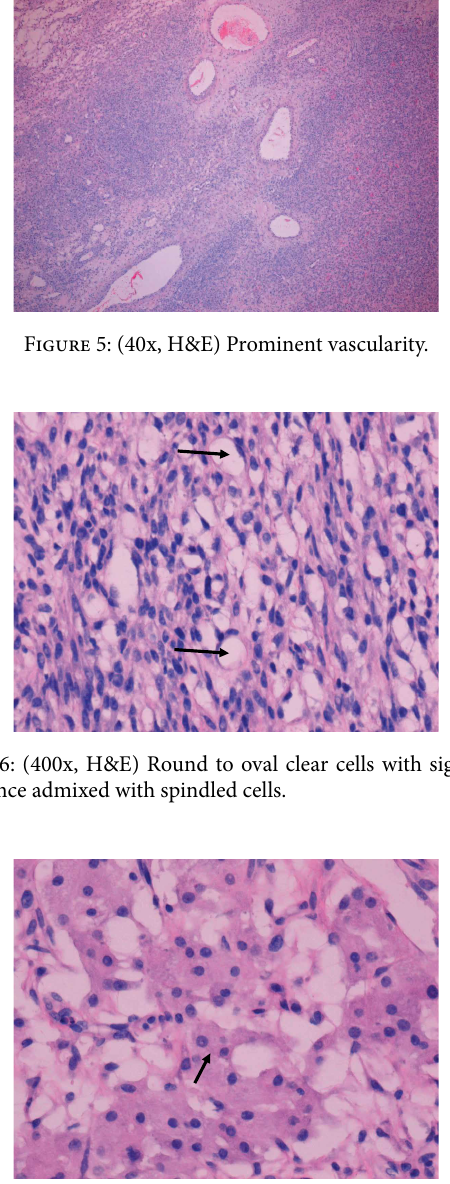
Figure 7: (400x, H&E) Plump, eosinophilic luteinized cells (black arrow).